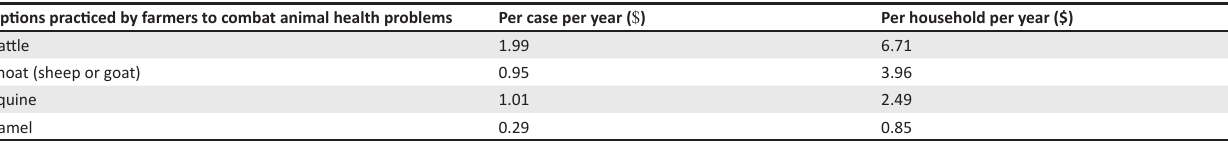
TABLE 2: Average cost (in US Dollars) incurred for animal disease, as estimated by respondents. Options practiced by farmers to combat animal health